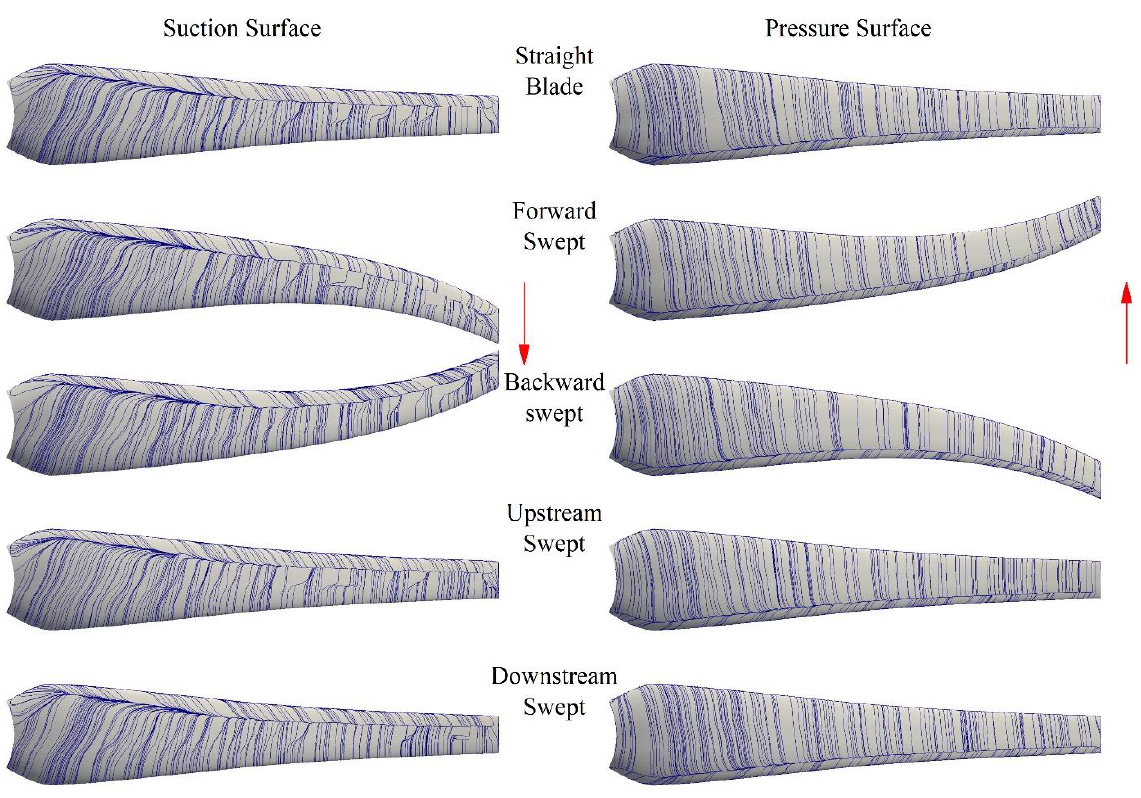
Figure 10. Surface streamlines above the straight blade and swept blades at TSR = 6, with the red arrows being the directions of the blades ’ rotation.